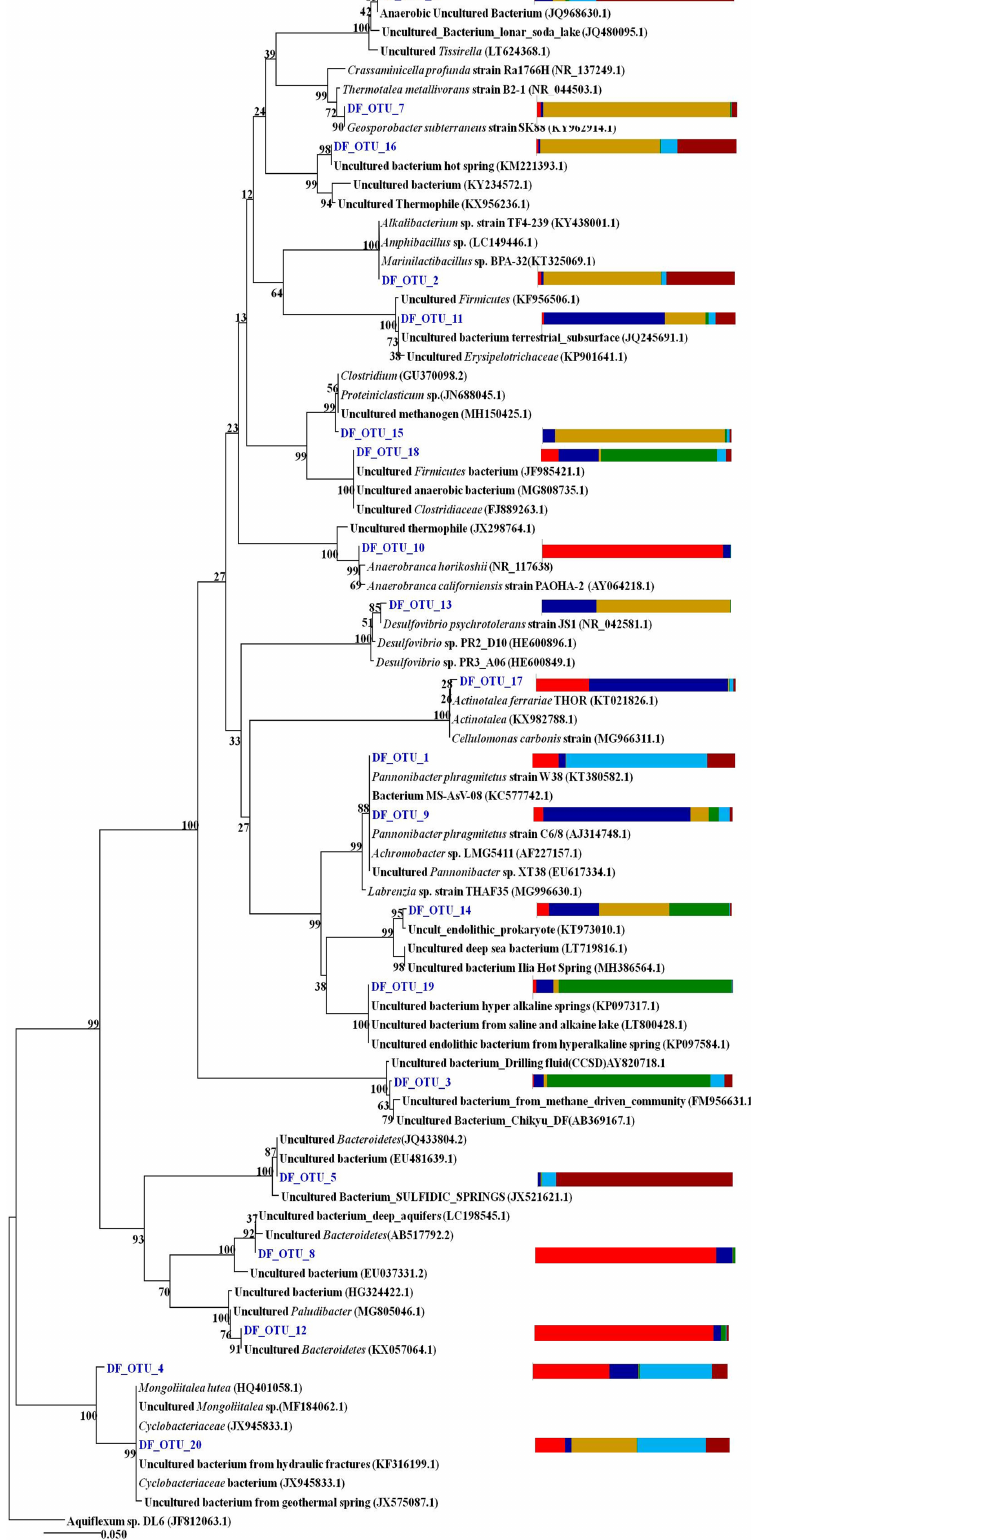
Figure 9. The phylogeny of the top 20 core OTUs (relative abundance > 82%) constructed in MEGA7. Coloured stack bar represent their relative abundance in all the DF samples. Each sample is represented by different colours as follows: DF1: red, DF2: blue, DF3: yellow, DF4: green, DF6: light blue, DF7: dark